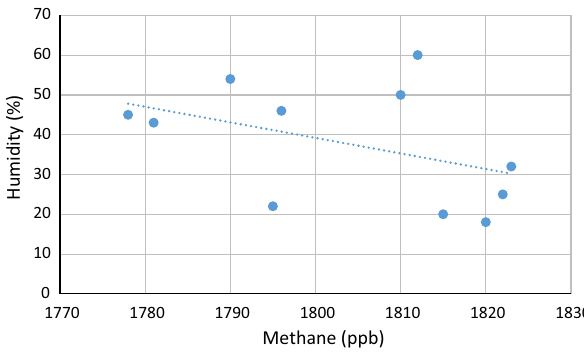
Fig. 7 Relationship between methane and NDVI in summer